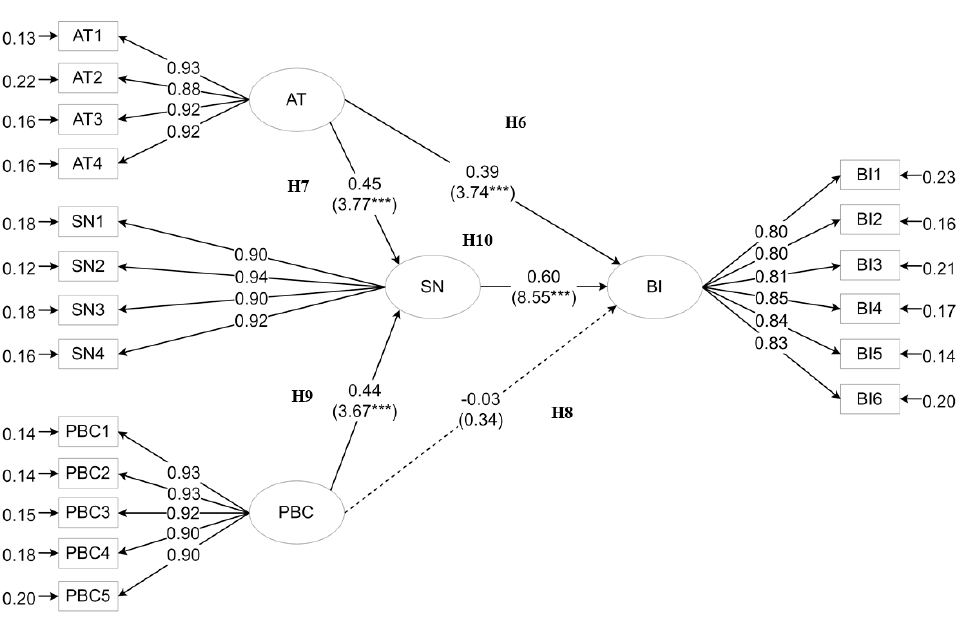
Figure 3. Path diagram of attitude (AT), perceived behavioral control (PBC), subjective norms (SN), and anti-PM2.5 behavioral intentions (BI) of parents from the rural areas in Beijing.